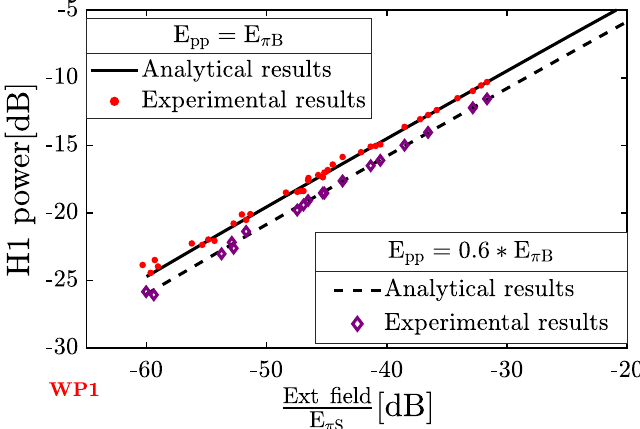
Figure 16. Comparison of the experimental and analytical